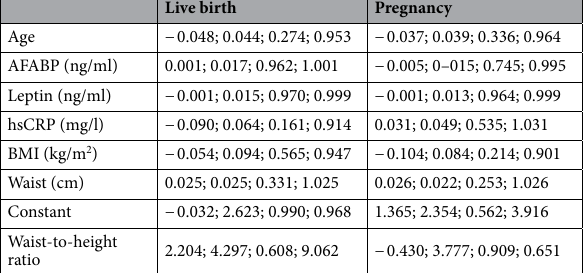
Table 3. Multivariable logistic regression analyses. Multivariate logistic regressions with live birth or pregnancy as dichotomous dependent variables. Values are: β; SE; P; OR. In a second analysis waist was replaced by waist-to-height ratio.